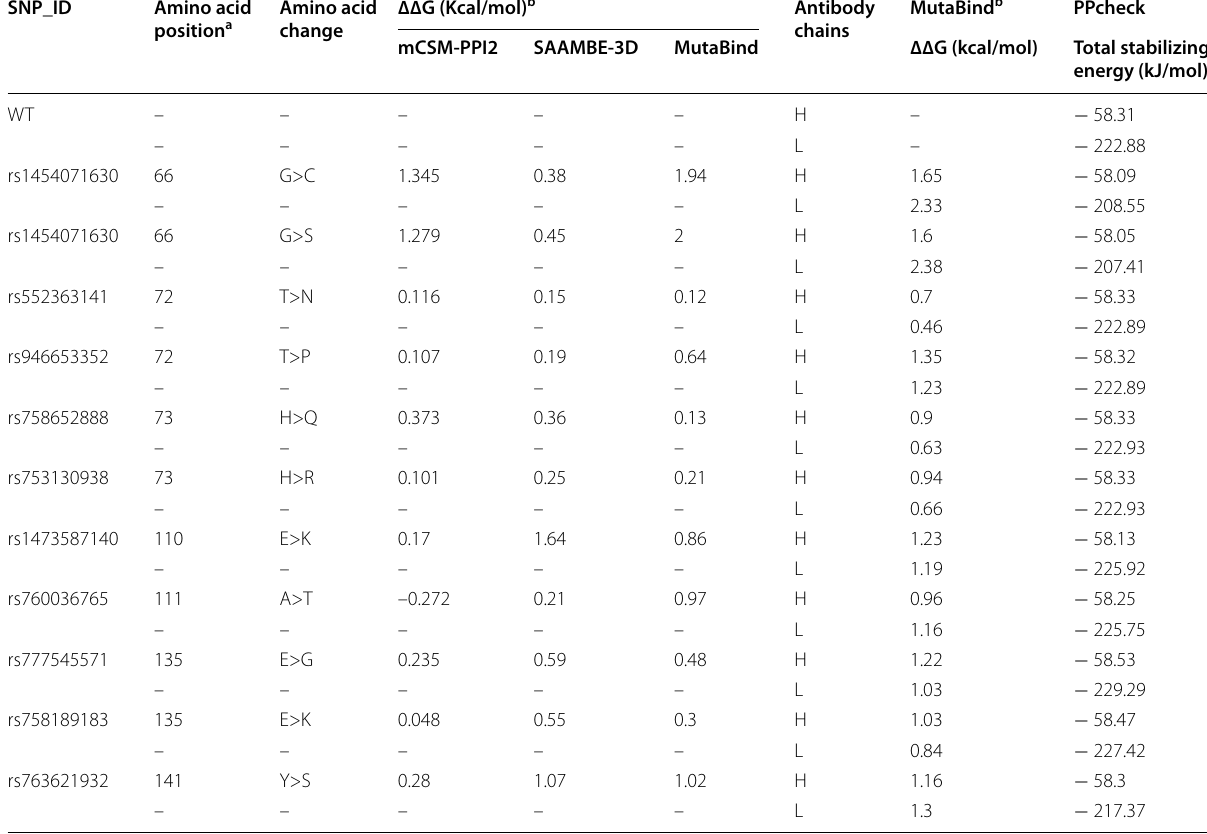
a Amino acid positions were calculated excluding the signal peptide (76 amino acids) b Positive values of ∆∆G indicate decreasing